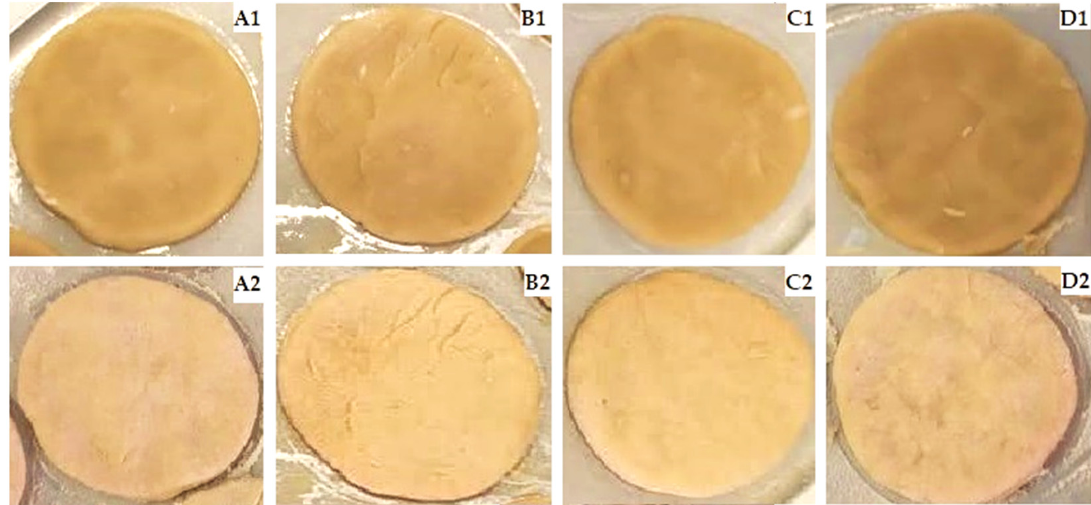
Figure 1. Cookies before ( 1 ) and after baking ( 2 ). ( A ): standard formulation; ( B ): formulation with 1% biosurfactant; ( C ): formulation with 0.5% biosurfactant; ( D ): formulation with 0.25% biosurfactant. Table 5. Physical properties of the cookies after baking for standard formulation, formulation A (1% biosurfactant), formulation B (0.5% biosurfactant) and formulation C (0.25% biosurfactant).